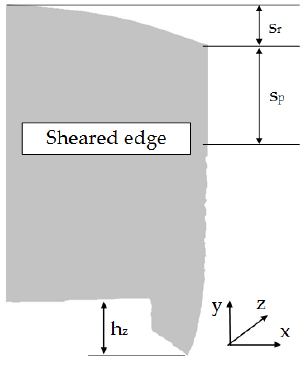
Figure 2. Typical sheared edge contour with characteristic areas, cross-sectional scheme; s r —roll-over, s p —sheared-burnished, h z —burr. s p —sheared-burnished, h z